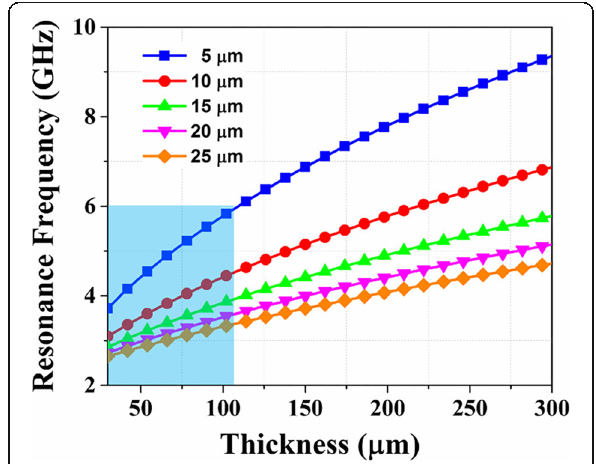
Fig. 5 Measured and calculated imaginary permeability for combined stripe patterned FeCoBSi thin film with T =45 nm and calculated imaginary permeability for stripes with different width. The red area corresponds to the resonance band (FWHM) of combined stripe patterned